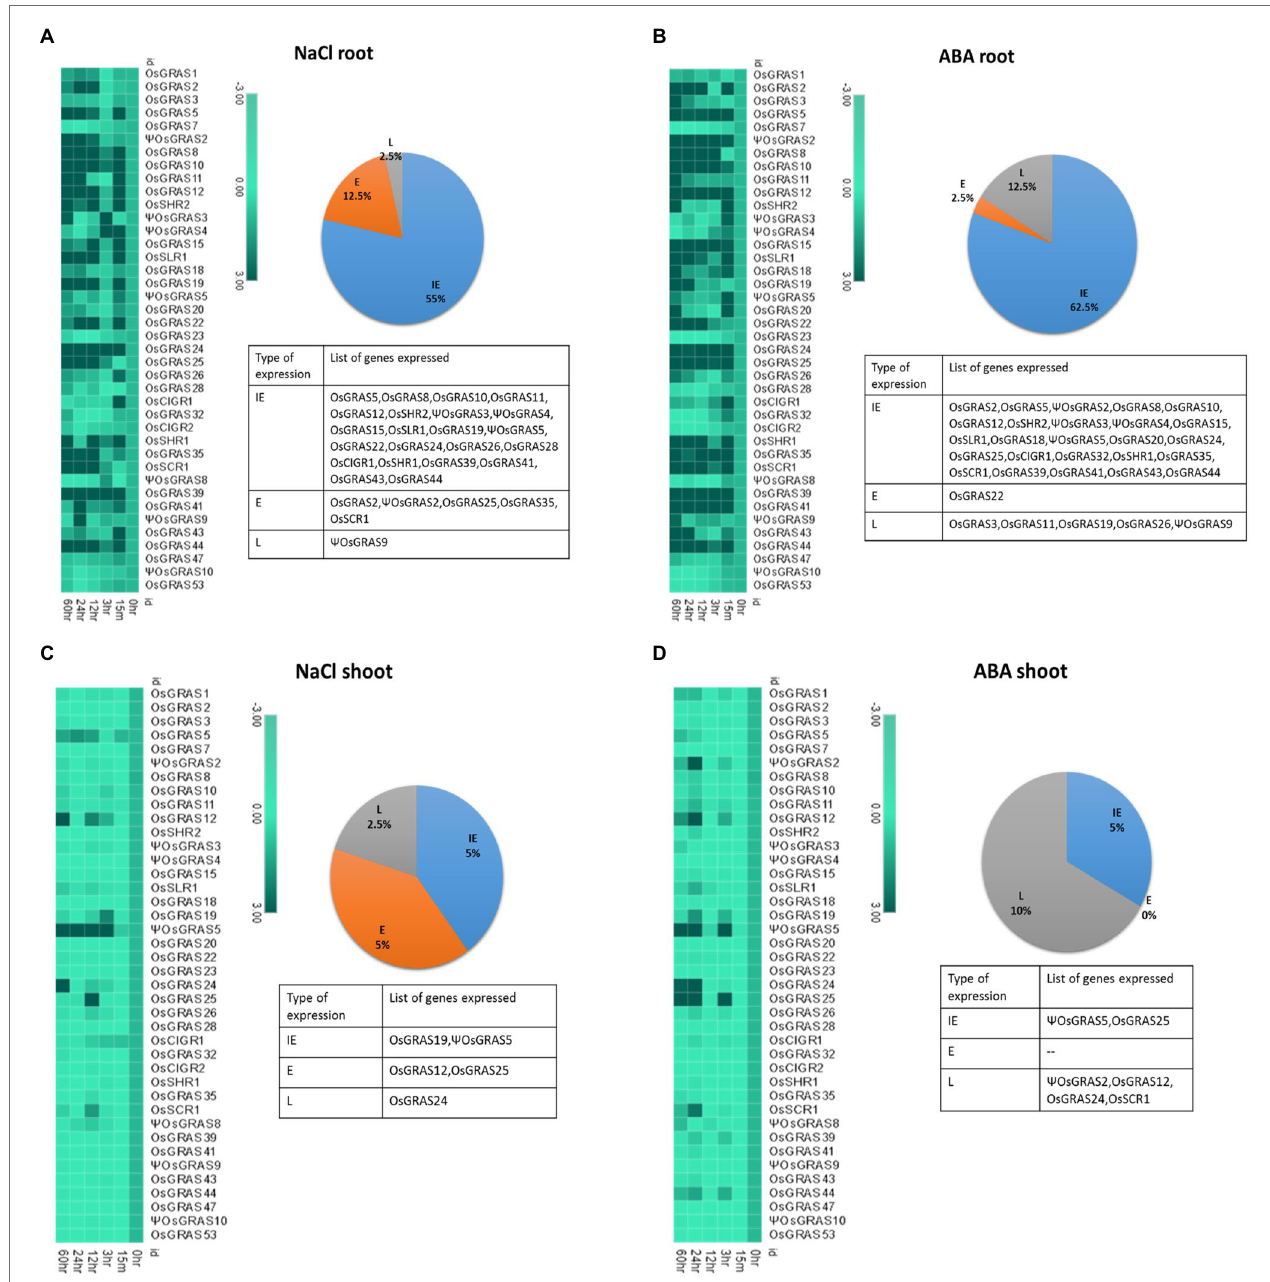
FIGURE 5 | Expression analysis of GRAS genes under abiotic stress. Heat map representation of temporal expression pattern of GRAS genes developed using MORPHEUS program. 7 d old seedlings were subjected to NaCl (250 μ m) and ABA (100 μ m) treatments and the obtained quantitative real-time values were double normalized using rice actin and tubulin as the internal reference genes and that of the unstressed samples using the ΔΔ C T method. The experiment was conducted separately for root (A,B) and shoot (C,D) tissues. Percentage of genes upregulated under NaCl and ABA treatments is represented in the form of a pie chart beside their corresponding heat maps. The genes were separated based on their time point(s) of expression and annotated as immediate early (IE), early (E) and late (L) expressive genes. The names of the genes is provided in the list below. The experiment was conducted using biological and technical triplicates ( n = 3), and the mean value was used to plot the heat map in the MORPHEUS